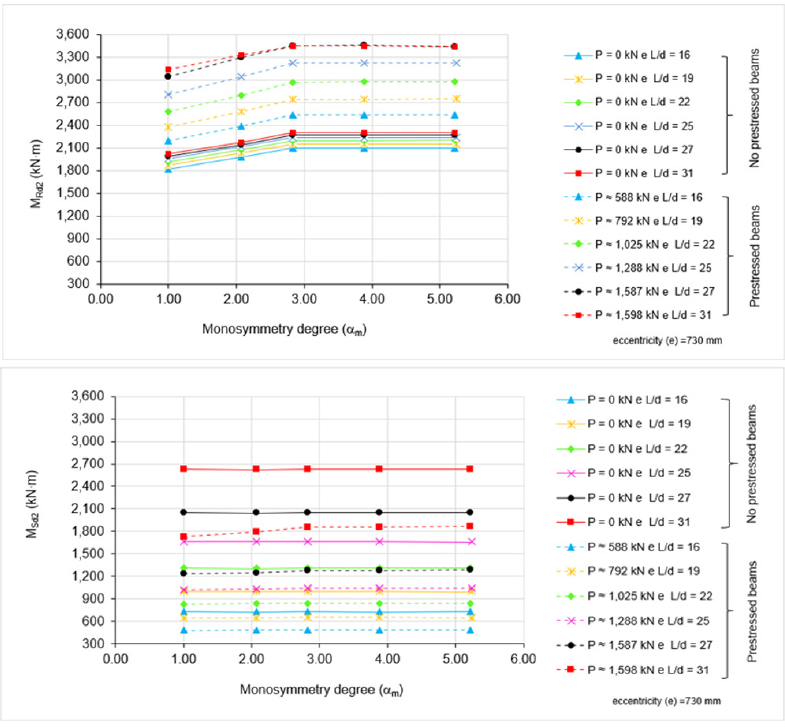
and versus monosymmetry degree graphs for e p = Figure 7. Rd M Sd M